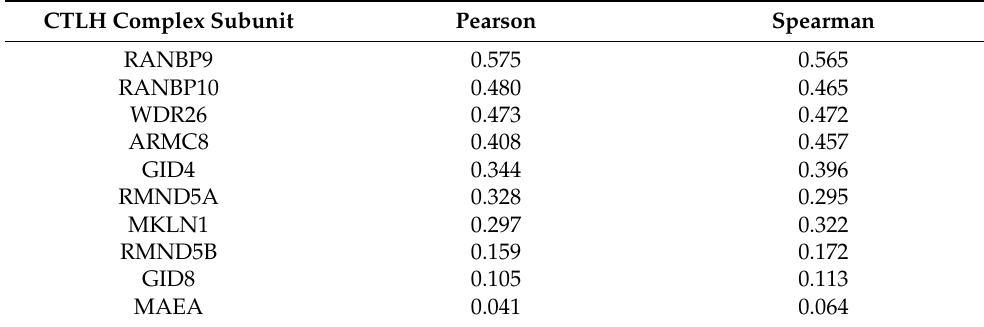
Table 1. CTLH complex subunit RNA protein-level correlation coefficients across cancer cell lines. Data obtained from Table S4 of Nusinow et al., 2020